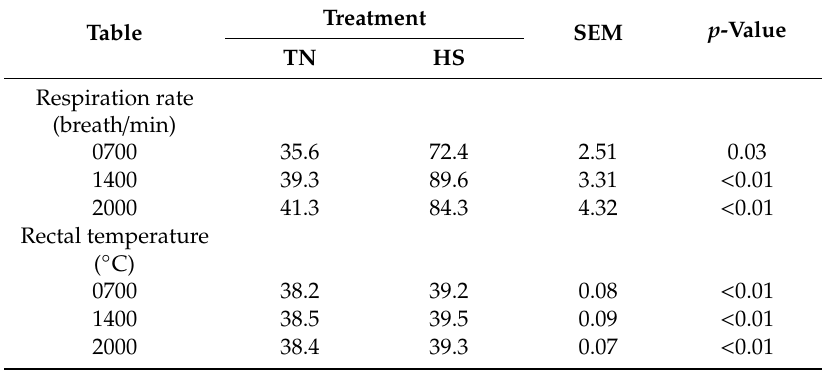
Figure 1. Temperature–humidity index at 07:00, 14:00, and 20:00 h, and mean. Table 3. Respiratory rate and rectal temperature of lactating Holstein cows in TN and HS groups.